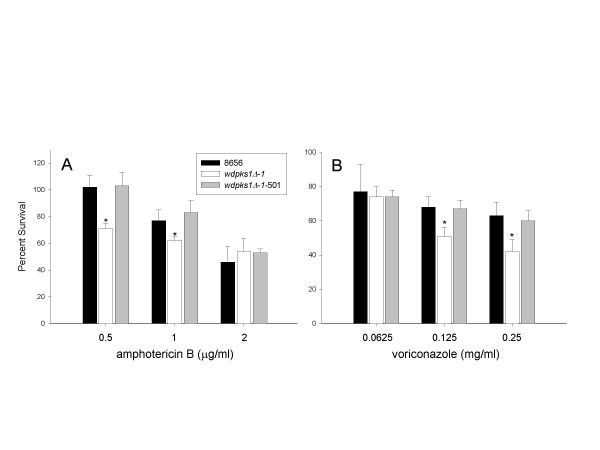
Antifungal drug time-kill assay. The rates of survival of strains 8656, wdpks1Δ-1, and wdpks1Δ-1-501 yeast cells grown for 7 days in YPD medium at 37°C after exposure to various concentrations of amphotericin B [A] or voriconazole [B] for 2 h compared to those of fungal cells incubated in PBS. Values are averages and brackets represent standard errors of the means for three measurements. P values were calculated by comparing wild-type and wdpks1Δ-1 cells using the Student's t test. *, p < 0.01. Similar results were obtained in three separate experiments.